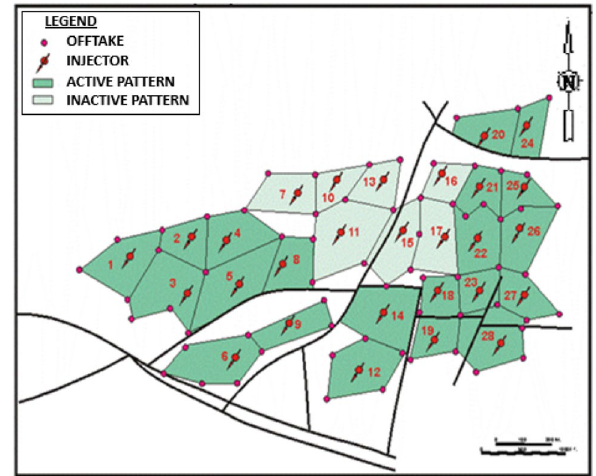
Fig. 3 Automatic alteration of fracture permeability under the opera- tion of the Barton–Bandis theory (adapted from CMG-GEM manual, 2016) Fig. 4 Well pattern map (adapted from SPE 89411—Ramlal